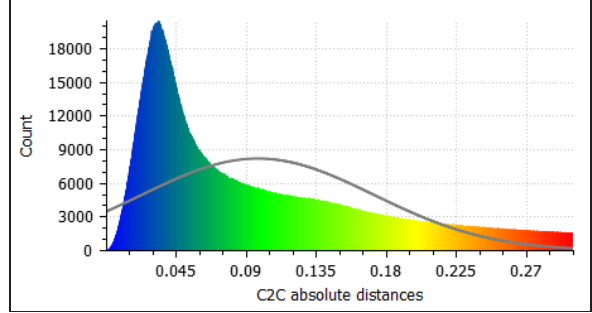
Figure 19. UAV/TIMMS histogram